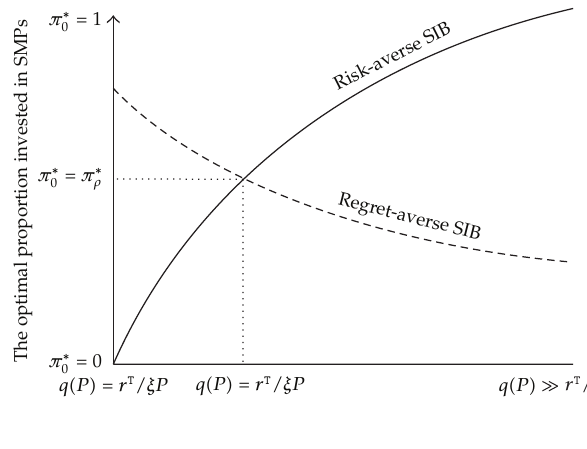
Figure 6: The Certainty